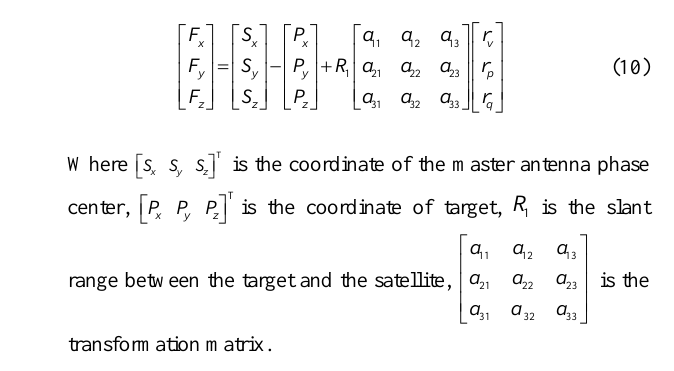
Figure 4. Flow chart of